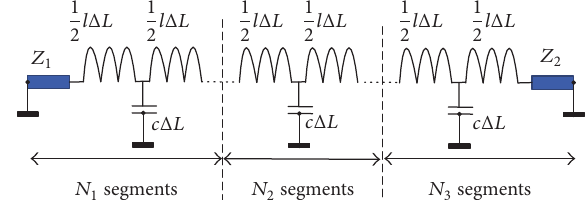
Figure 3: Two adjacent metallic rectangular enclosures (enclosure 1 and enclosure 2 with a covered aperture 2 at the right wall) connected by a metallic plate with a covered aperture 1 excited by an electric dipole in enclosure 1 and with a two-conductor TL outside enclosure